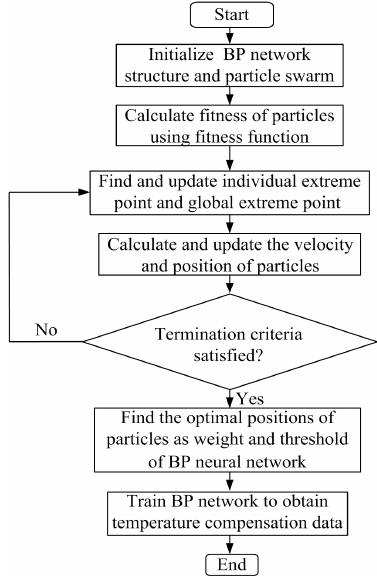
Figure 12. Flowchart depicting the particle swarm optimization–back-propagation (PSO–BP) neural network algorithm. network